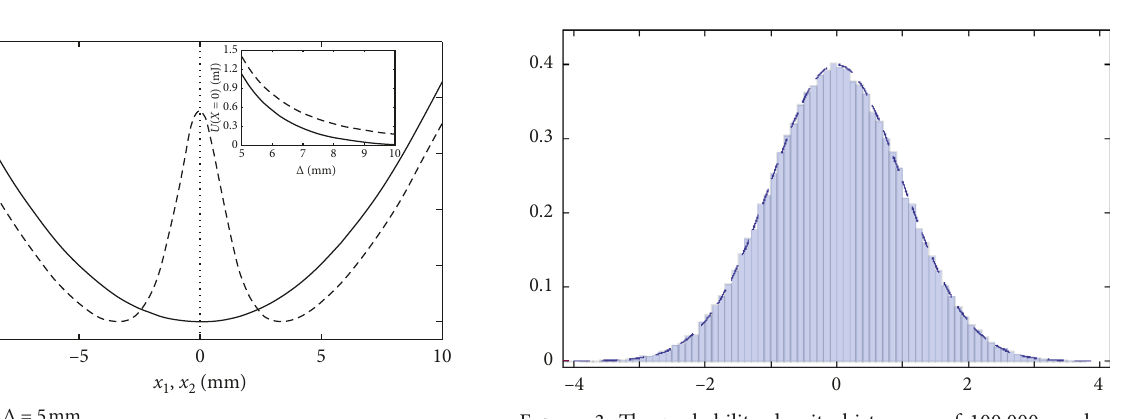
Figure 3: The probability density histogram of 100,000 random numbers used in our computations. The dashed line represents a normal distribution function with the mean value equal to 0 and a standard deviation equal to 1.